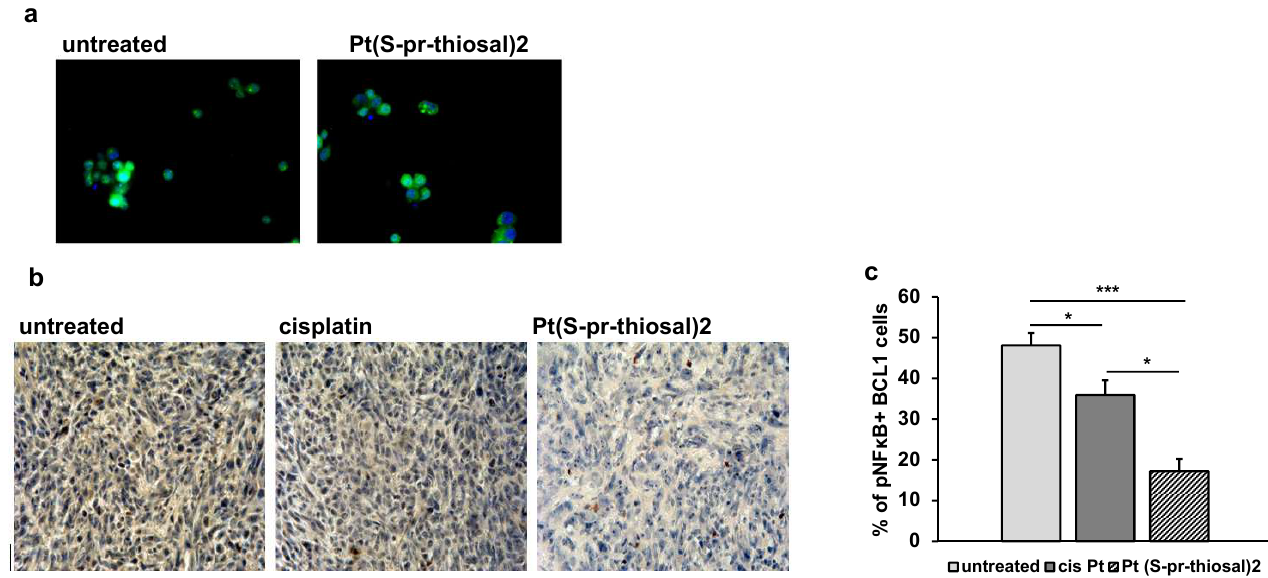
Figure 7. The expression of the phosphorylated form of NF- κ B is decreased in BCL1 cells after exposure to Pt( S -pr-thiosal)2. ( a ) Immunofluorescence (green stained phosphorylated NF- κ B and DNA stained blue) (DAPI)) BCL1 cells untreated and treated with platinum complex for 12 h, magnification 200 × . ( b ) Representative images of phosphorylated NF- κ B expression in tumor tissue (detected by immunohistochemistry) in the lungs of untreated mice and mice treated with cisplatin and Pt( S -pr-thiosal)2, four weeks after intravenous administration of BCL1 cells. ( c ) The percentage of positive cells (expressing NF- κ B) in relation to the total number of tumor cells in the field of view presented as the mean values + SD for 5 mice per group. Statistical significance was determined by Student’s t test; * p < 0.05; *** p <